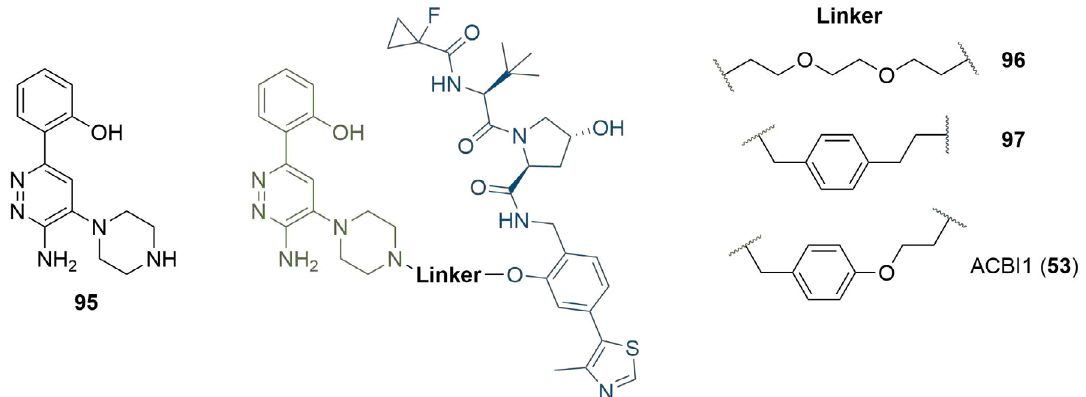
Figure 20. Use of co-crystal structure to guide changes to linker composition. The crystal structure of 95 in complex with SMARCA2 BD identified the piperazine ring as suitable for conjugation. The PEG linkage in 96 was replaced with a benzyl to improve hydrophobic interactions and exploit a potential pi-stack to Y98 in VHL (97). Extension by one atom to obtain the